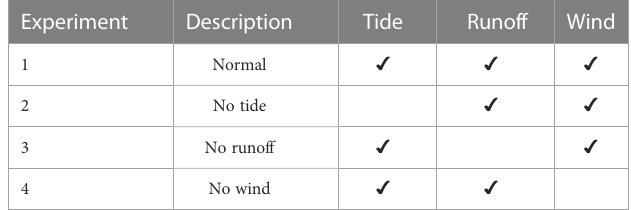
TABLE 2 List of